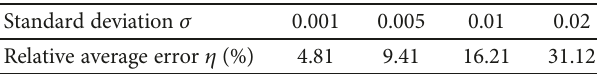
Figure 10: Impacts of di ff erent measuring errors on inversion results when L = 0 01m and R = 3 . Table 3: Relative average error of inversion results of di ff erent measuring errors when L = 0 01 m and R = 3